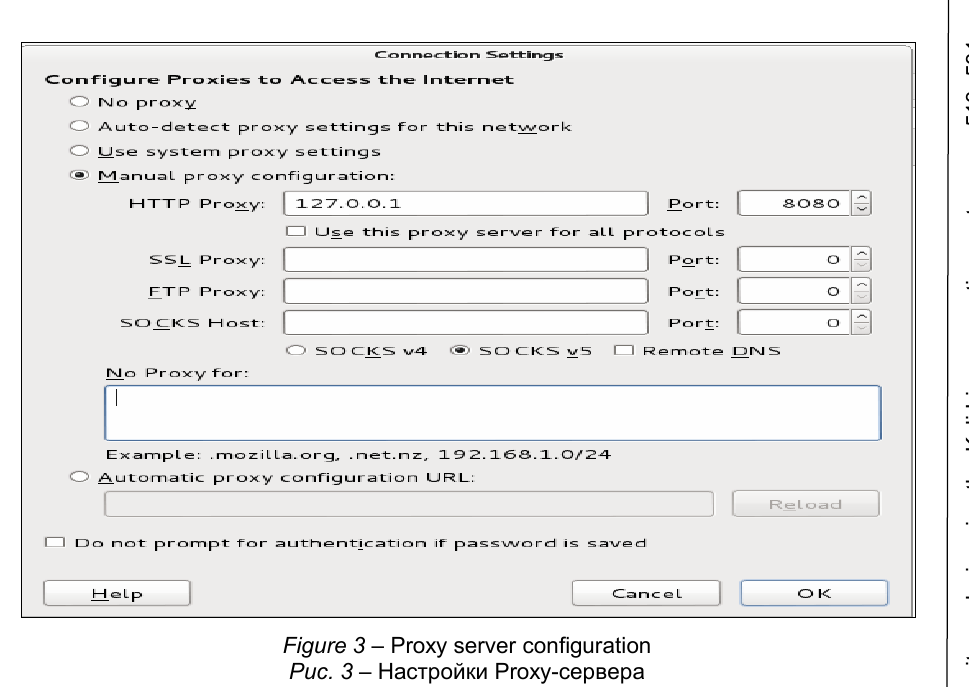
Figure 3 – Proxy server configuration Рис . 3 – Настройки Proxy-